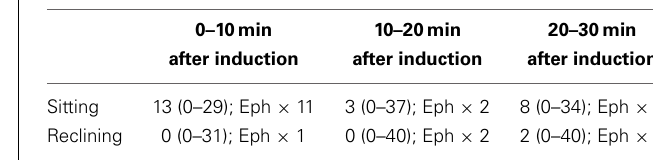
Table 3 | Number of 15s periods per patient with MAP < 60mmHg, (median and range); and the number of ephedrine (Eph) administrations during three consecutive 10min